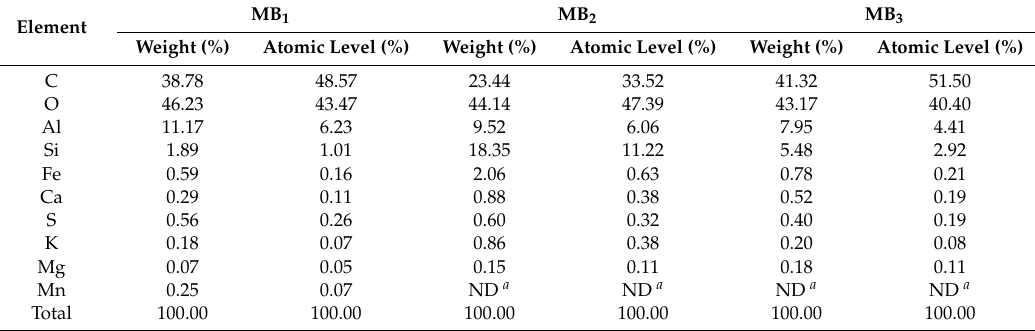
Table 3. EDS results of the harvested and dried MB samples in the surface water of the three water treatment